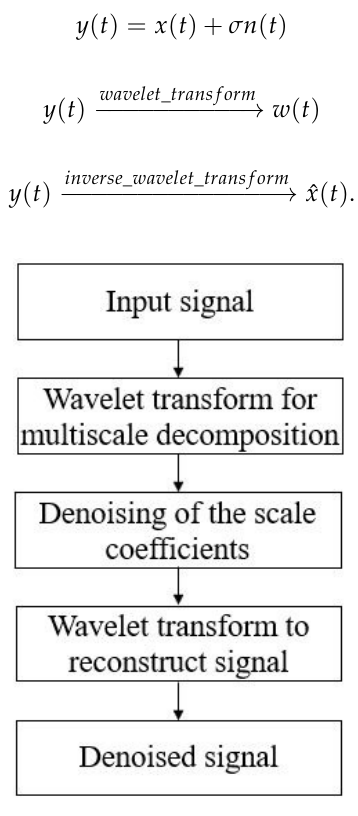
Figure 2. Steps for signal